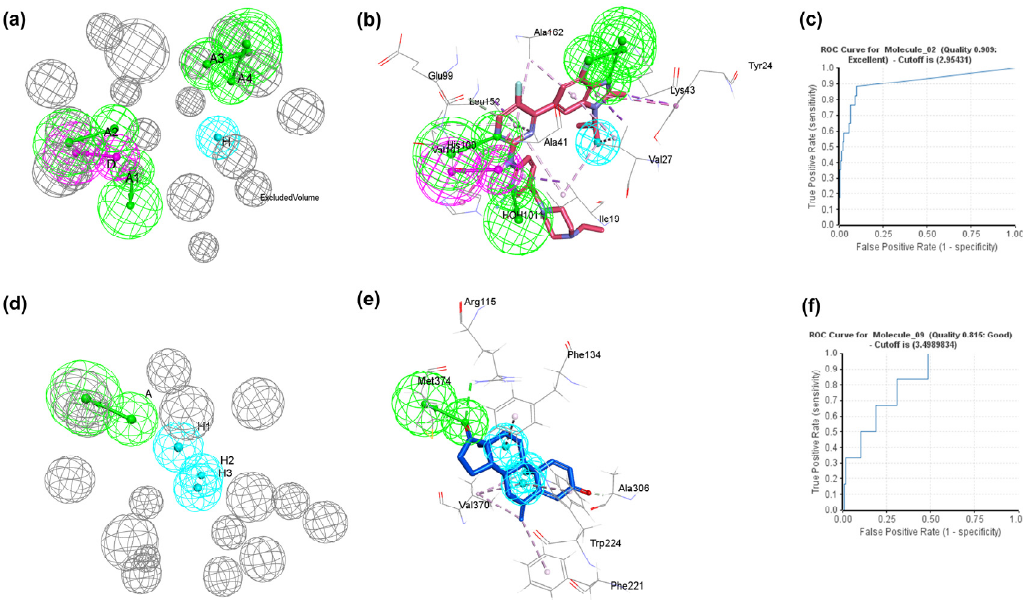
Figure 4 . Representation of pharmacophore models. ( a ) Pharmacophore _02model (AAAADH) of CDK6 protein with six pharmacophoric features; ( b ) pharmacophore_02 model in complex with co-crystal abemaciclib (PDB ID:5L2S); ( c ) ROC curve of the validation of pharmacophore_02 model; ( d ) pharmacophore_09 model (AHHH) of aromatase with four pharmacophoric features; ( e ) pharmacophore_02 model in complex with co-crystal exemestane (PDB ID:3S7S); ( f ) The validation ROC curve for the pharmacophore_09 model. Magenta, green, and cyan represent hydrogen bond donor (D), hydrogen bond acceptor (A), and hydrophobic (H) features, respectively. The grey color represents the excluded volumes.